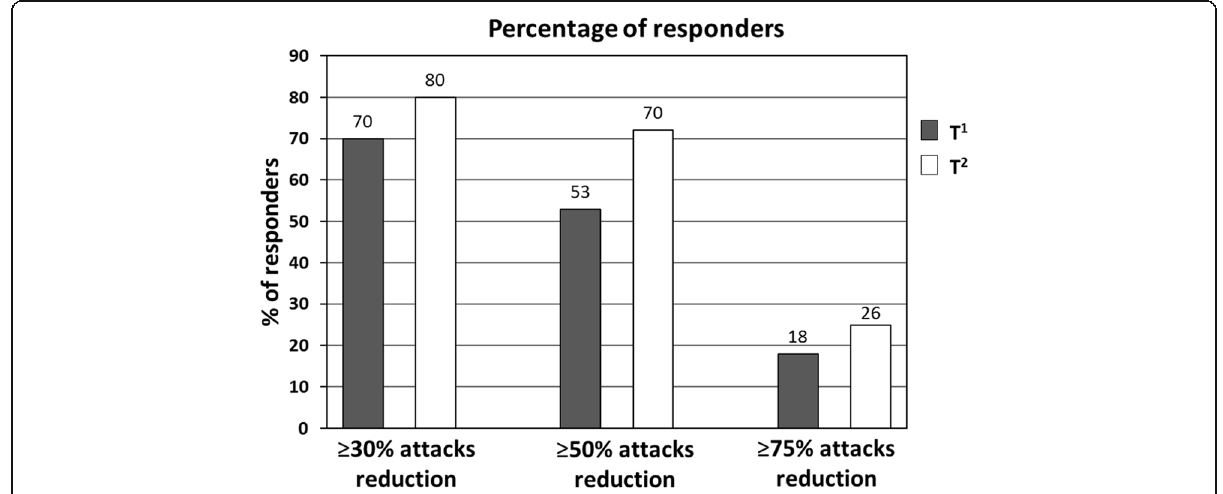
Fig. 1 Primary outcome: Percentage of responders at the end of the third (T 1 ) and of the sixth month (T 2 ) of erenumab administration